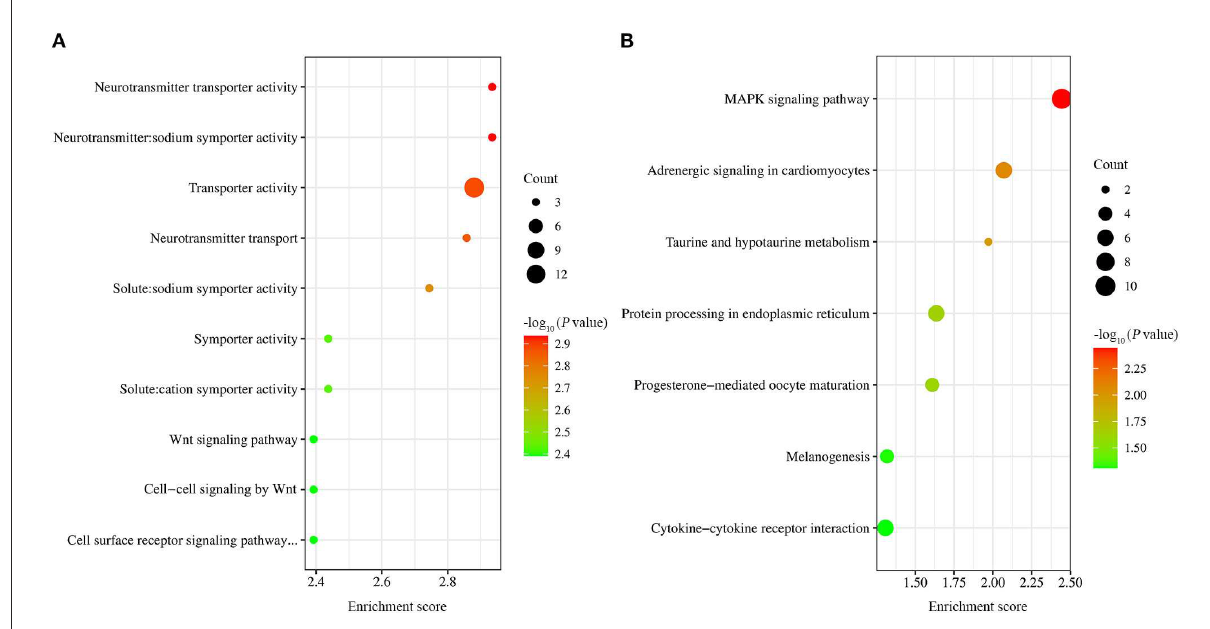
FIGURE4 GO and KEGG analysis of DEGs. (A) The top ten GO terms with the most significant P -values. (B) The seven significantly enriched signaling pathway.